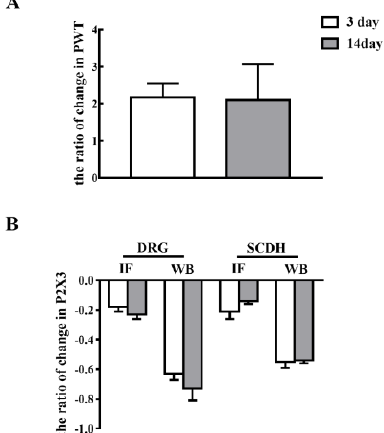
Figure 6. Short-term and long-term EA stimulation treatments exerted comparable effects on pain hypersensitivity and P2X3 expression. ( A ) The ratio of changes in PWT after 100 Hz EA stimulation for 3 and 14 days. ( B ) The ratio of changes in P2X3 after 100 Hz EA stimulation for 3 and 14 days. Data are presented as the mean ± SEM.